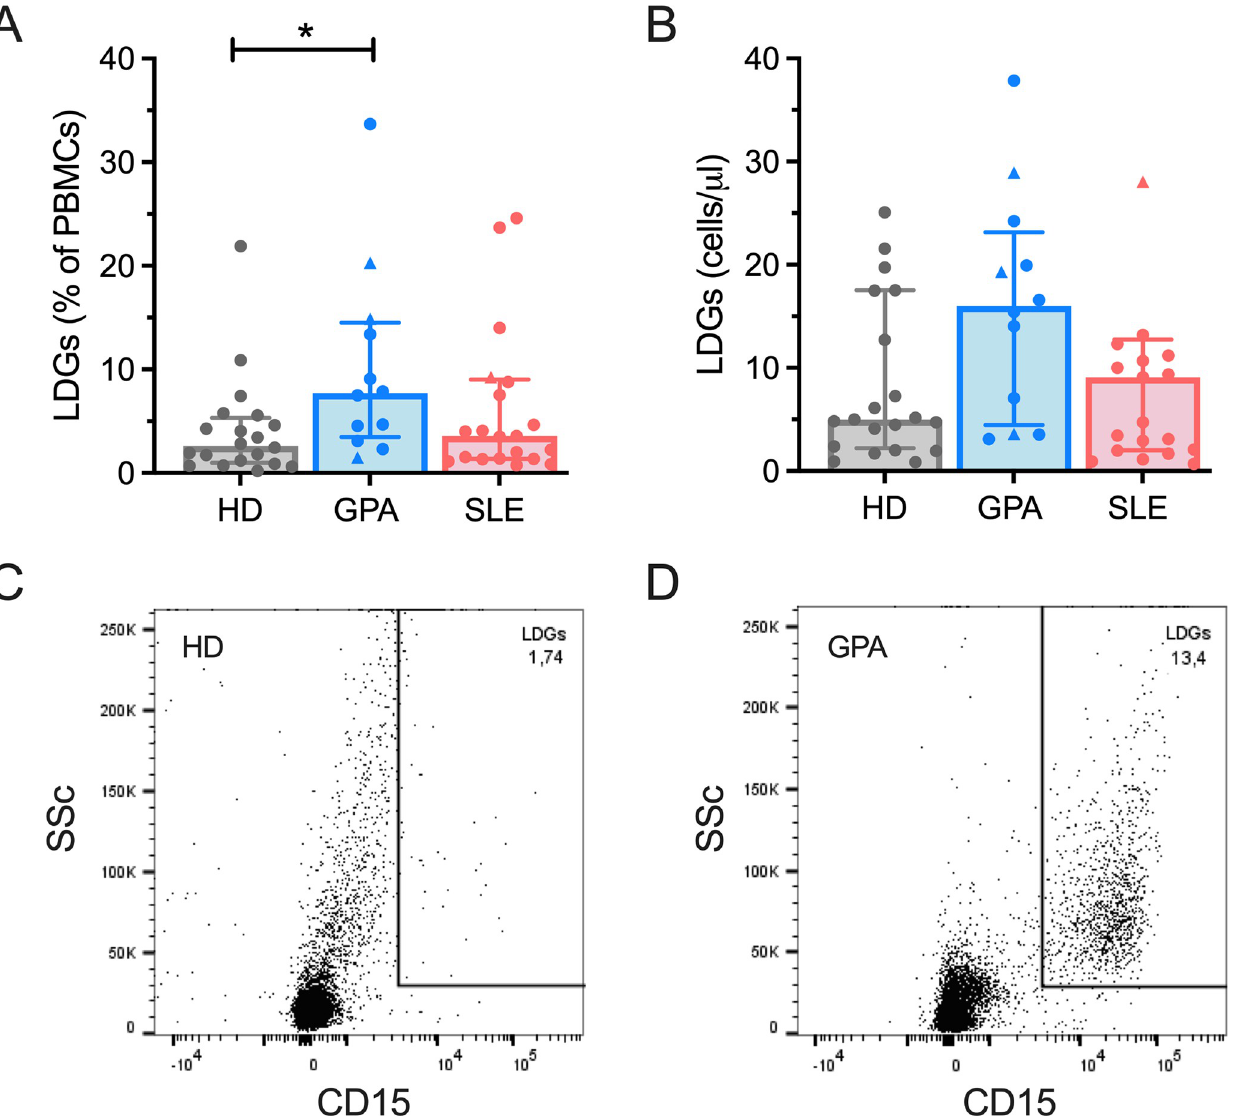
Fig 1. Quantification of LDGs. Percentage (A) and absolute numbers (B) of LDGs in peripheral blood (HD, n = 21; GPA, n = 12; SLE, n = 21). LDGs were defined as CD15 + SSC hi cells in the PBMC-layer of Percoll-separated blood by FACS, as previously reported (33). Each dot represents one measured patient sample. Pateints receiving prednisolone dosages of � 20mg daily (3 patients with GPA and one patient with SLE) are indicated by triangles. Bars indicate median, error bars represent interquartile range. Data were analyzed by Kruskal-Wallis-test ( α = 0.05), � p < 0.05, �� p < 0.01.Representative figures for the detetction of LDGs in a healthy donor (C) and a patient with GPA(D) are provided.